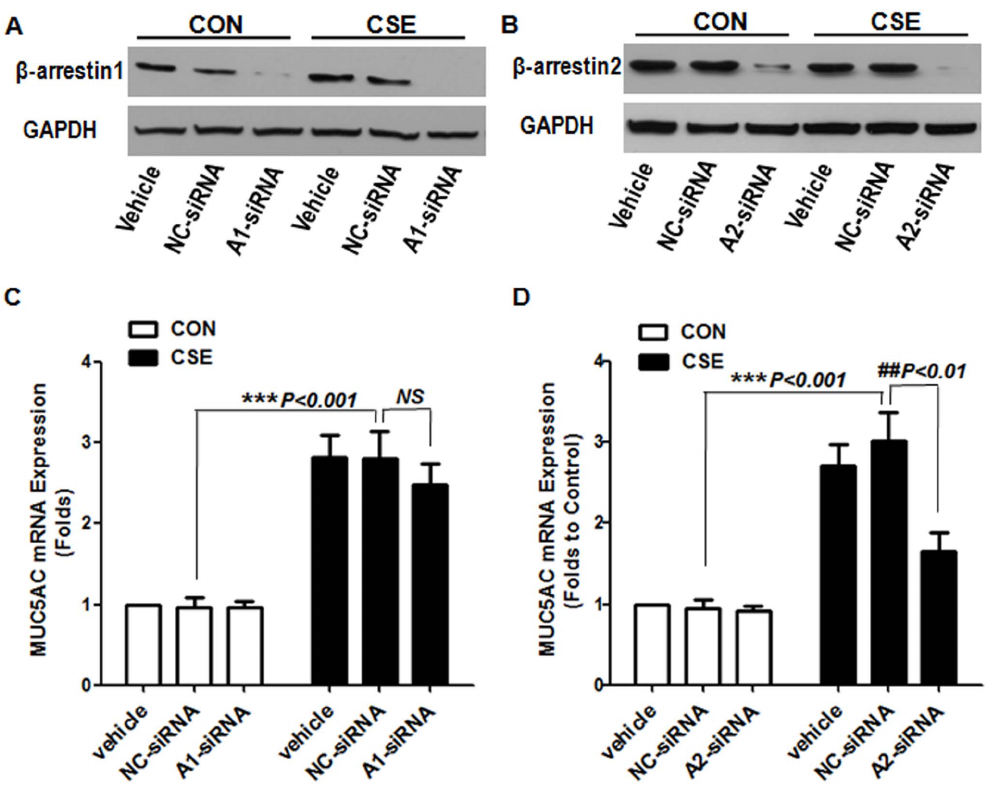
Figure 4. Effect of b -arrestin knockdown on CSE-stimulated MUC5AC expression. Cells were transfected with Lipofectamine2000 alone (vehicle), a nonspecific control siRNA (NC-siRNA, 100 nM), b -arrestin1–targeted siRNA (A1-siRNA, 100 nM) or b -arrestin2–targeted siRNA (A2-siRNA, 100 nM) for 48 h before incubation with or without CSE for 24 h. (A, B) Western blot analysis of b -arrestin1 and b -arrestin2 protein level to access the knockdown efficiency. (C, D) Quantitative RT-PCR analysis of MUC5AC mRNA expression. Data are means 6 SEM (n=3). NS, not